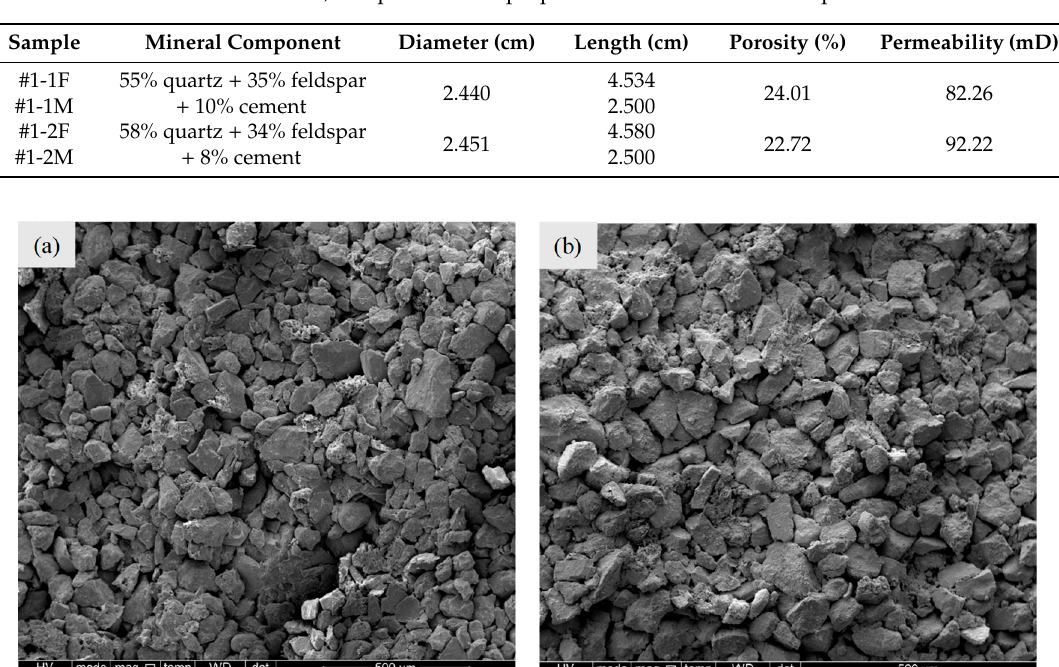
Table 1. Sizes, components and properties of the sandstone samples.